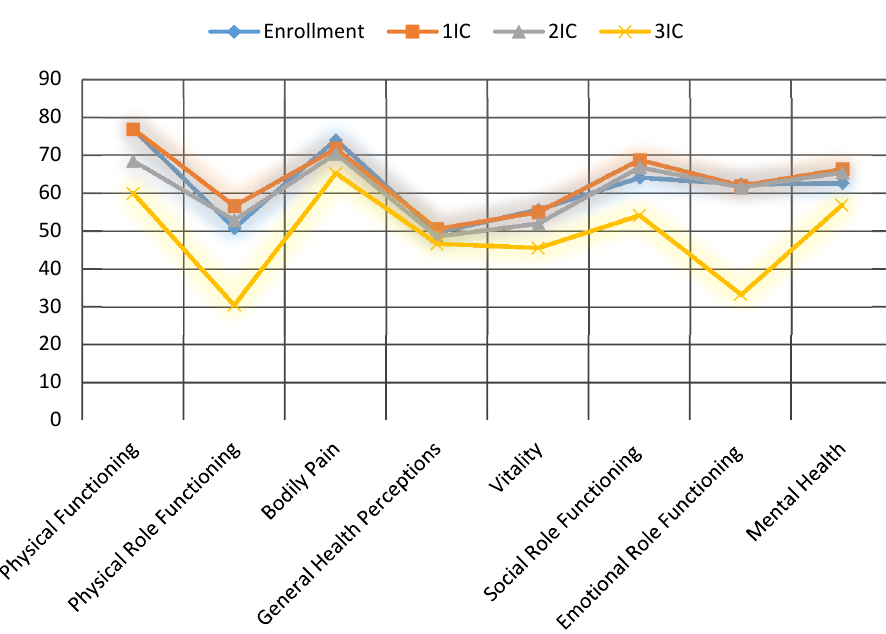
Figure 6. Trend of the median values of tumor markers after each PIPAC procedure.